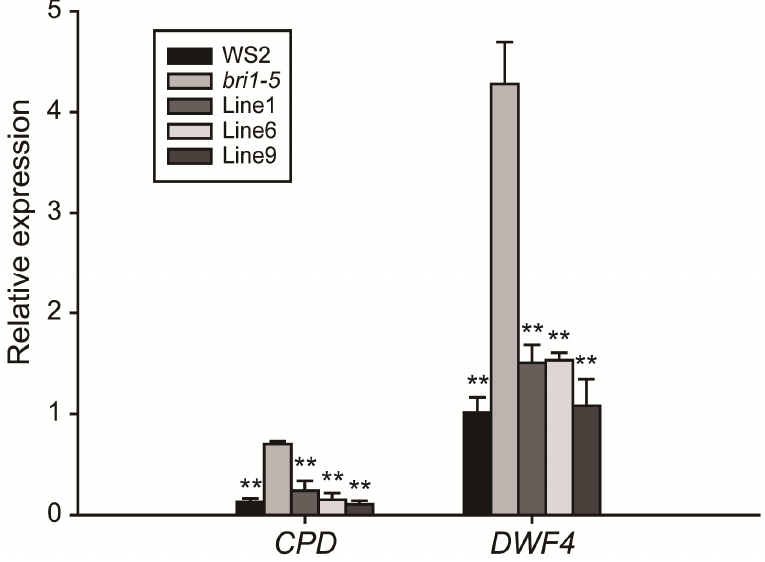
6. Real-time quantitative reverse transcriptase polymerase chain reaction (qRT-PCR) analysis of the BR-related marker genes, DWF4 and CPD , in the wide-type (WS2), bri1-5 mutant and three transgenic lines (Line 1, 6 and 9). The relative expression levels are normalized to AtACTIN2 (GenBank accession No. AT3G18780). The data represents the mean ± SD of three independent experiments. The asterisks indicate significant differences compared to the bri1-5 mutant ( ** , p < 0.01 by the t